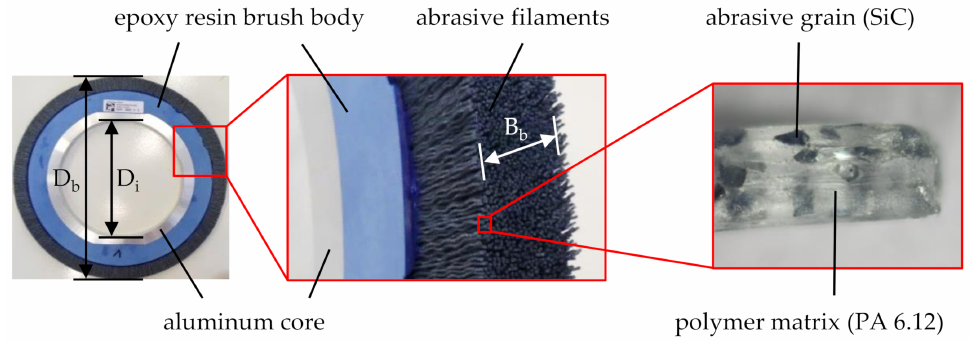
Figure 1. Layout of a circular abrasive brush tool